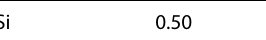
Table 1 Chemical composition of the “ as casted ” Al6061 — in wt.%